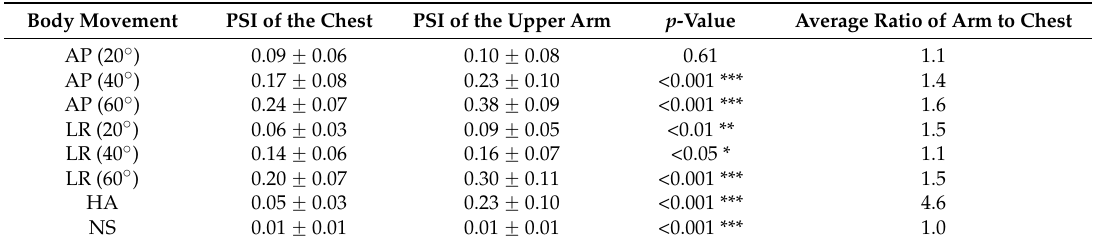
Table 1. The PSI results of the first experiment. Data is represented as mean ˘ STD (unit is g, gravitation). Body Movement PSI of the Chest PSI of the Upper Arm p -Value Average Ratio of Arm to Chest